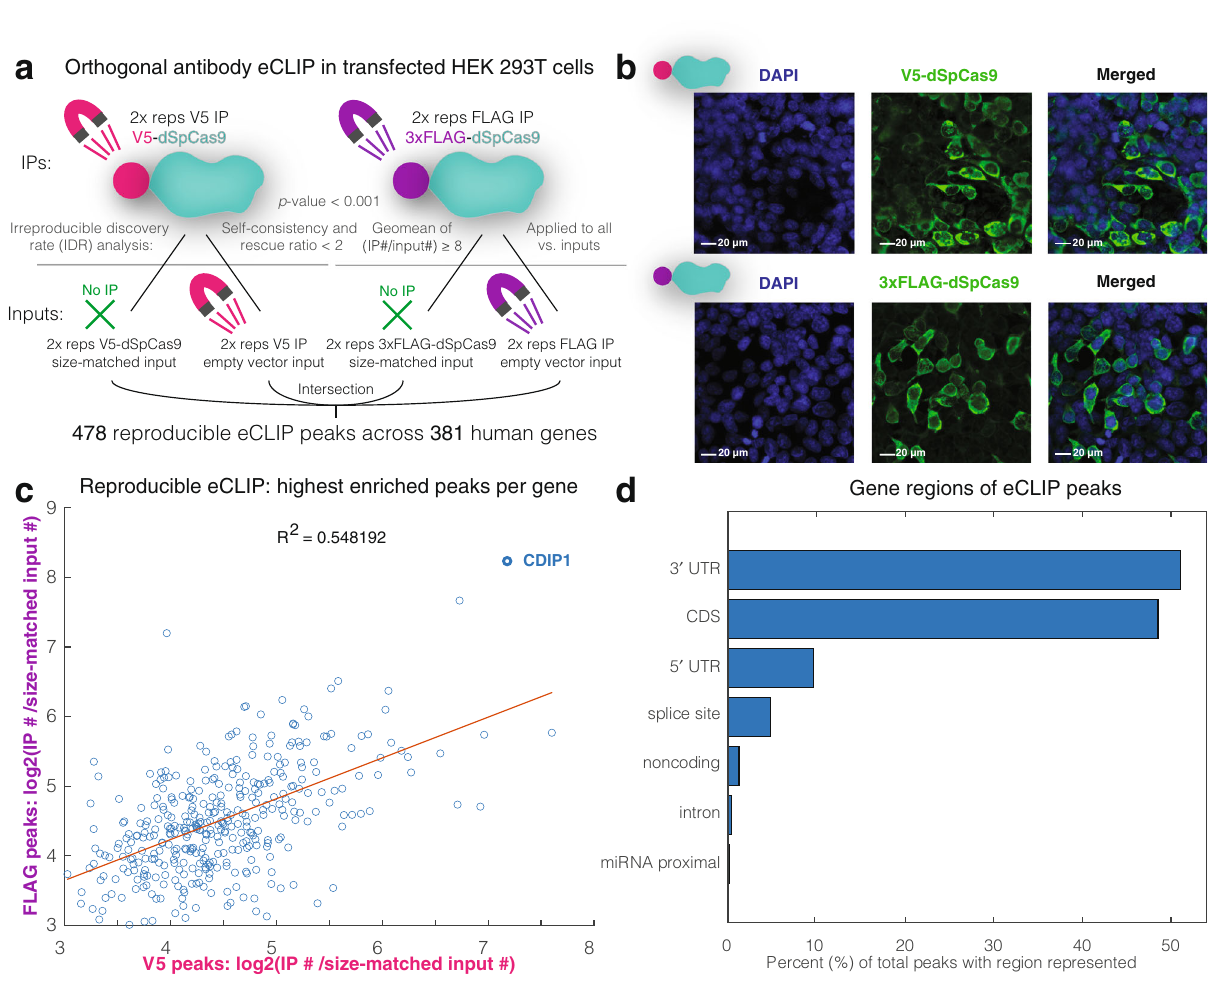
Fig. 1 An orthogonal antibody eCLIP reveals transcriptome-wide Cas9-human RNA interactions. a Orthogonal V5/FLAG dSpCas9 eCLIP (enhanced eCLIP) experimental design. The experiment in transfected HEK 293T cells found 478 reproducible peaks across 381 human genes. All eCLIPs were performed in two bioreplicates per condition and were designed with two controls: size-matched inputs from dSpCas9 transfections; and antibody immunoprecipitations of empty vector transfections. b Immuno fl uorescent imaging of expressed V5/3xFLAG-dSpCas9 displays predominantly cytoplasmic cellular localization of dSpCas9 in HEK 293T cells. Experiments were performed independently in triplicate with similar results, with a representative image shown. c Highest enriched peak per gene log2(IP read count/size-matched input read count) enrichment score for V5 vs. FLAG eCLIPs. CDIP1(Cell Death Inducing p53 Target 1) is the top hit. d Gene regions of eCLIP peaks, with 3 ′ UTR the most